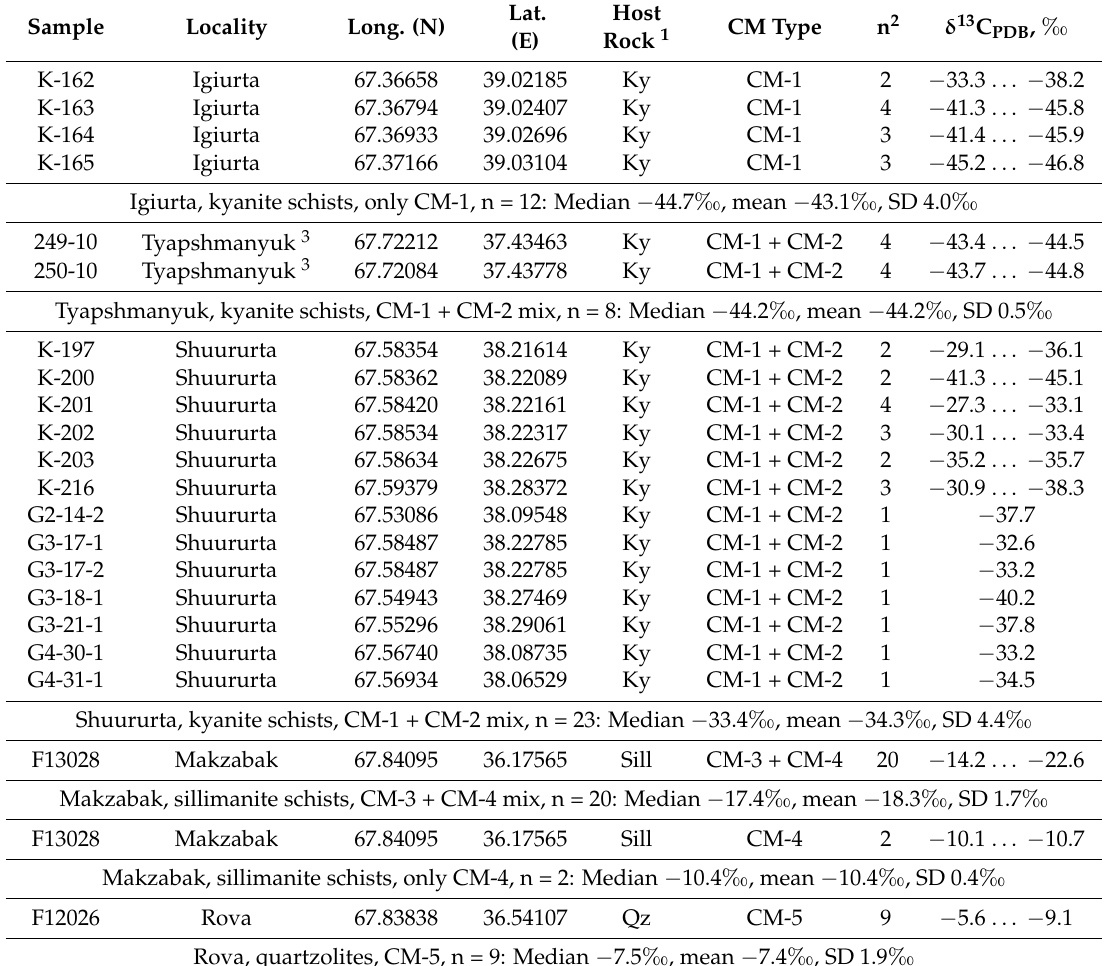
Table 1. Carbon isotope composition of CM from the Keivy